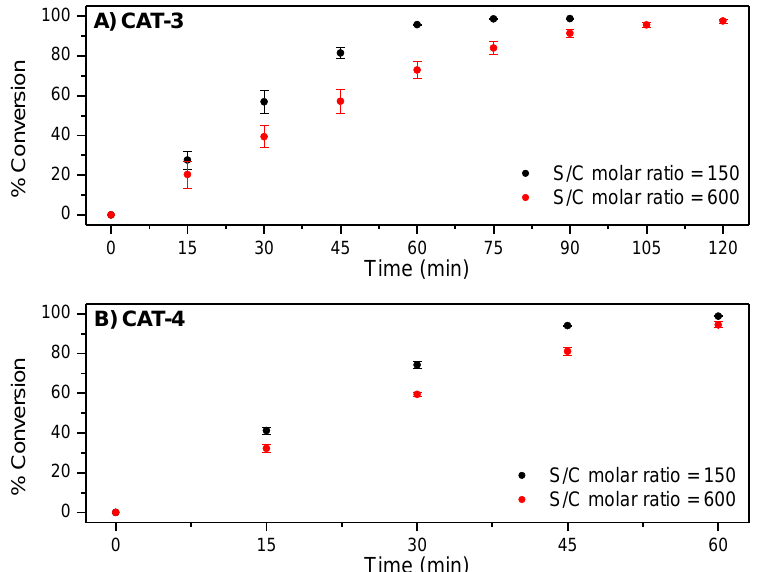
Figure 7. Comparison of the catalytic efficiency for the oxidation of cyclooctene with H 2 O 2 catalysed by ( A ) CAT-3 and ( B ) CAT-4 . Data correspond to mean values of at least three non-simultaneous replicates and the vertical bars correspond to the standard deviations.